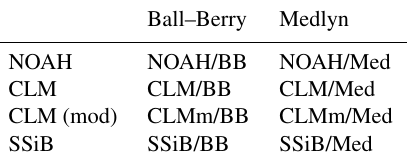
Table 3. Summary of the LPJ-GUESS/LSM simulations carried out. Simulations with different stomatal conductance schemes are arranged in columns: Ball–Berry (BB) and Medlyn (Med). Simu- lations with different water uptake response function types are ar- ranged in rows: NOAH, CLM, modified CLM, and